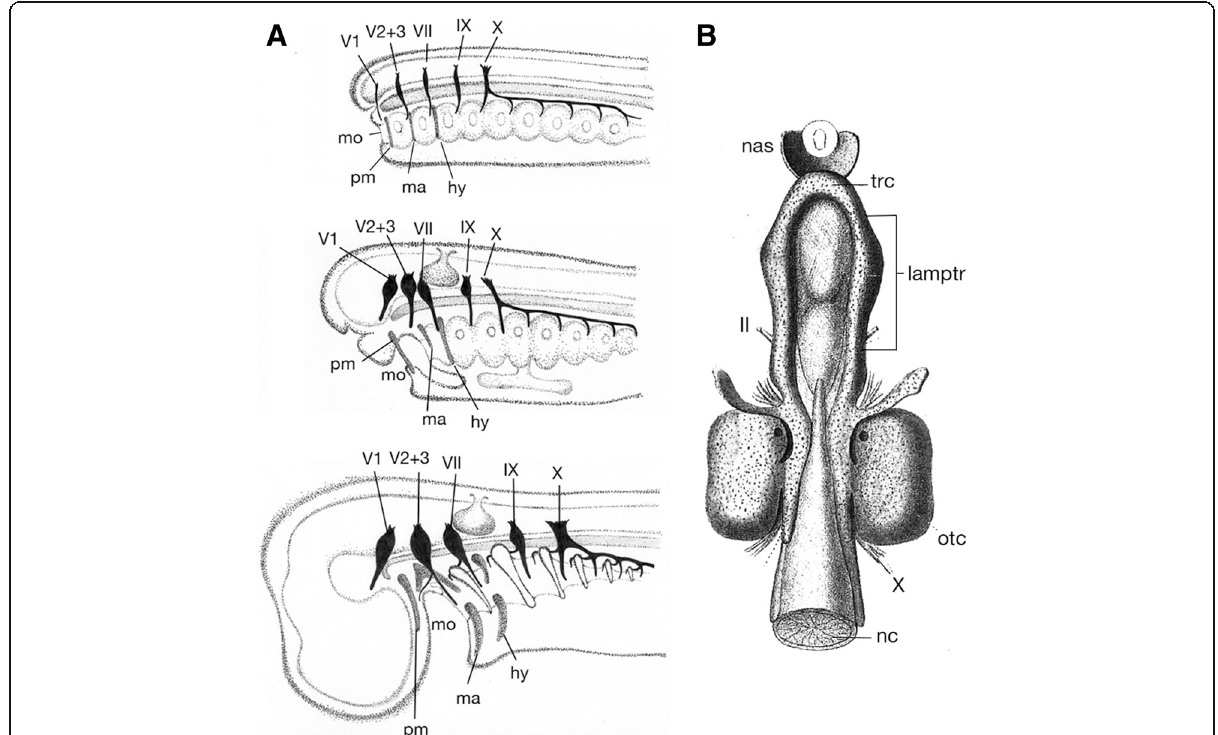
Fig. 2 Evolution of the vertebrate neurocranium and origin of trabecula. a Scenario by de Beer. From top to bottom, amphioxus-like vertebrate ancestor, ammocoete larval-like intermediate state, and gnathostome morphotype resembling an elasmobranch pharyngula. The trabecula is assumed to represent the premandibular arch, which was secondarily incorporated into the neurocranium of the gnathostome whose forebrain is expanded enormously. Based on reference [11]. b The neurocranium of the adult lamprey, which is primarily formed of an inverted U-shaped ‘ lamprey trabecula ’ , rostrally connected with its counterpart by means of the rostralmost portion called, in the present paper, the ‘ transverse commissure ’ . The latter part is assumed to be of premandibular mesoderm and homologous with the orbital (acrochordal) cartilage of jawed vertebrates, and the rest of lamprey trabecula is thought to correspond to a rostrally extended parachordal. This figure is based on reference [31]. Abbreviations: hy, hyoid arch; II, optic nerve; IX, glossopharyngeal nerve; lamptr, lamprey trabecula; ma, mandibular arch; mo, mouth; nas, nasal capsule; nc, notochord; otc, otic capsule; pm, hypothetical premandibular arch by De Beer [11]; trc, transverse commissure; V1, ophthalmic nerve; V2 + 3, maxillomandibular nerve; VII, facial nerve; X, vagus